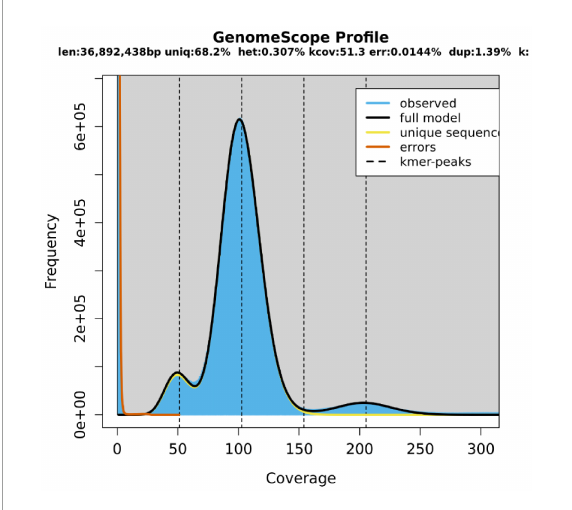
FIGURE4 The map of the gene coding gene BUSCO evaluation